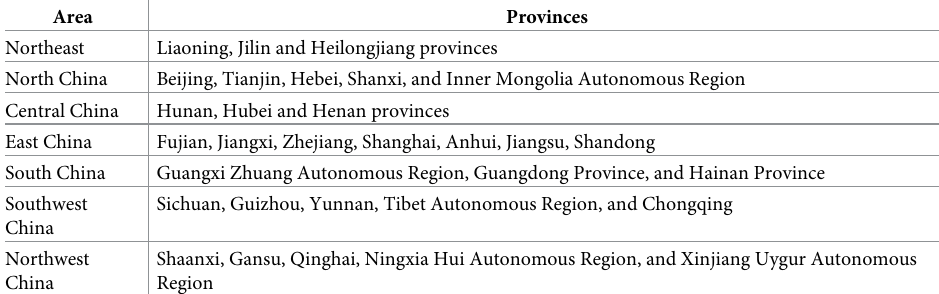
Table 1. Seven geographical regions of